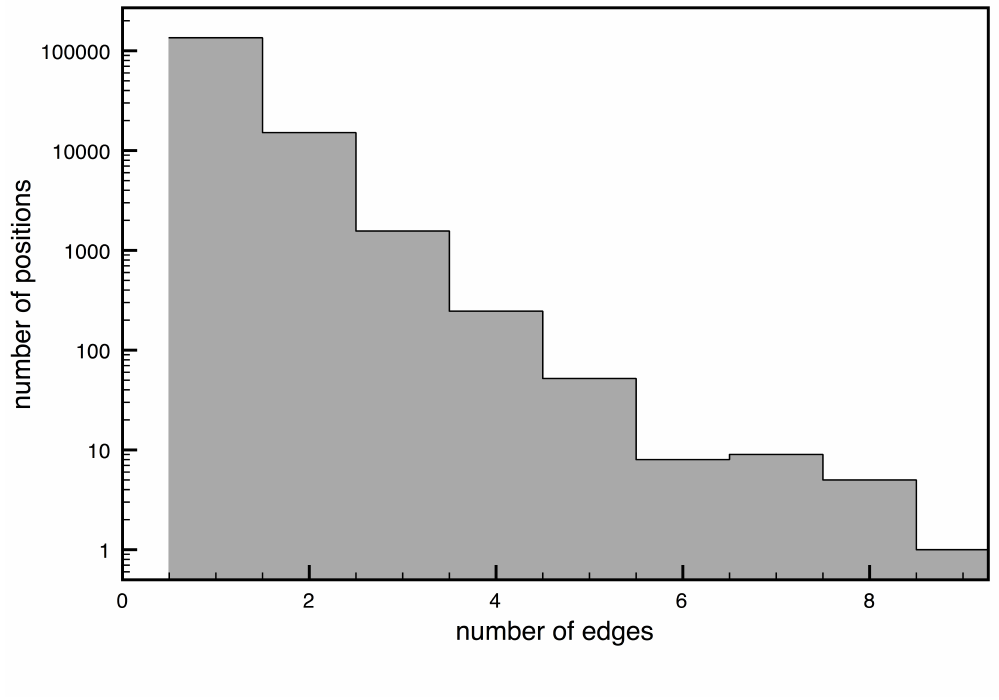
Figure 3. The X axis are the number of different symbols that expand to one position, the Y axis the number of positions that have this number of expansions. Note that Y is in logarithmic